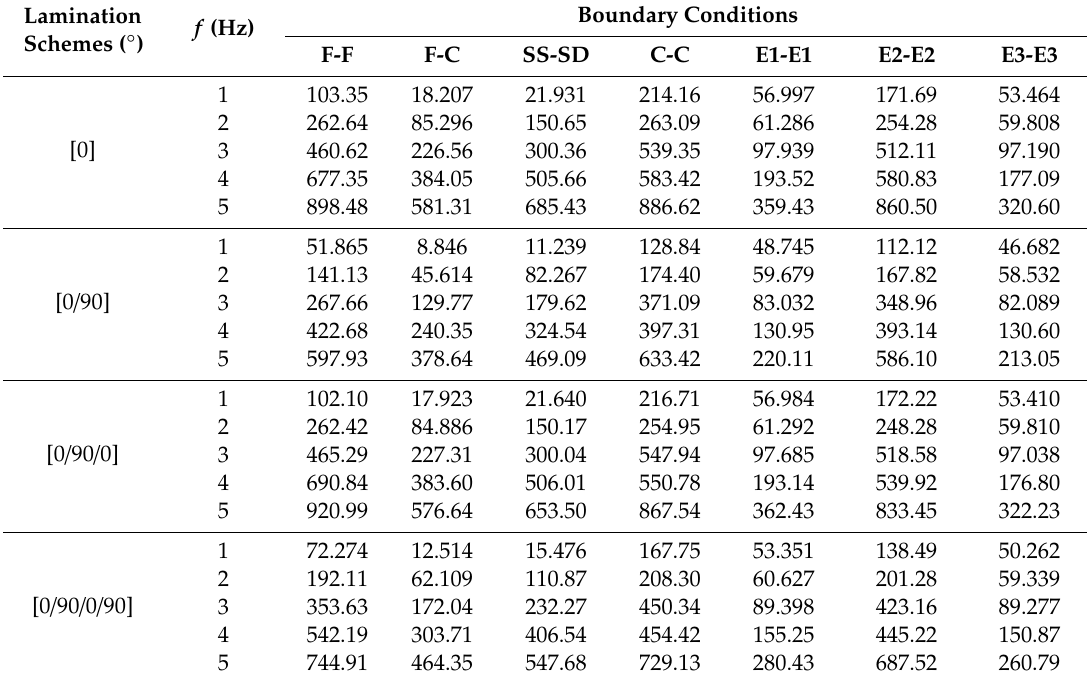
Table 5. Frequencies (first five modes) for an elliptical curved laminated composite beam with diverse lamination schemes and boundary conditions.